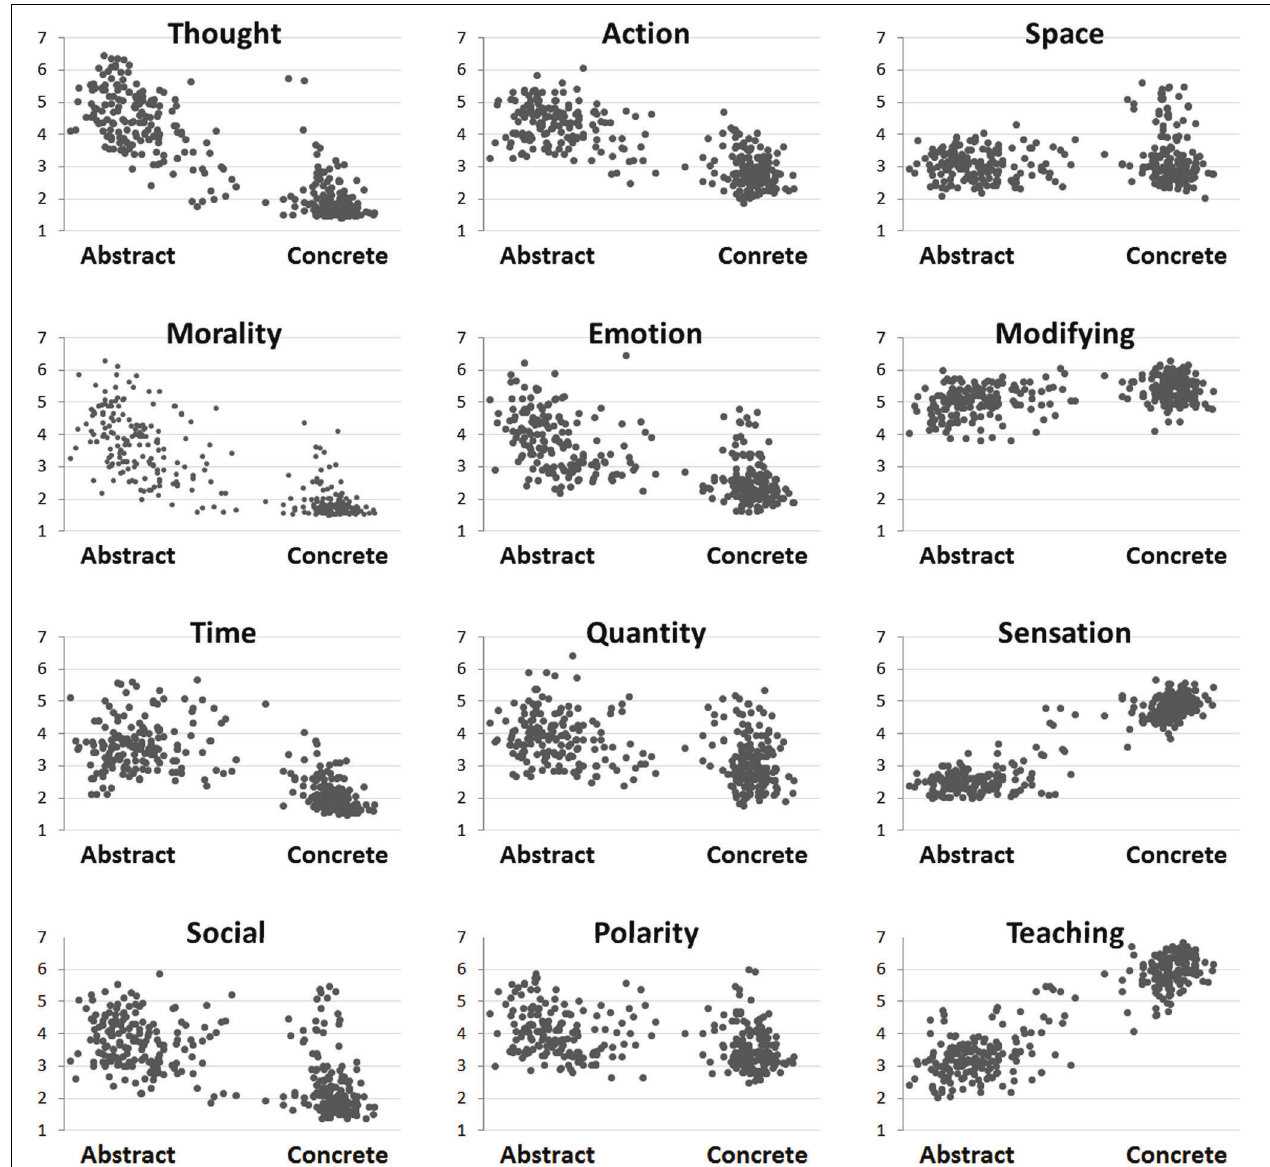
FIGURE 1 | Scatterplots of mean Likert scale ratings (1–7; y-axis) for each of the 12 rating dimensions for words from across the concreteness spectrum